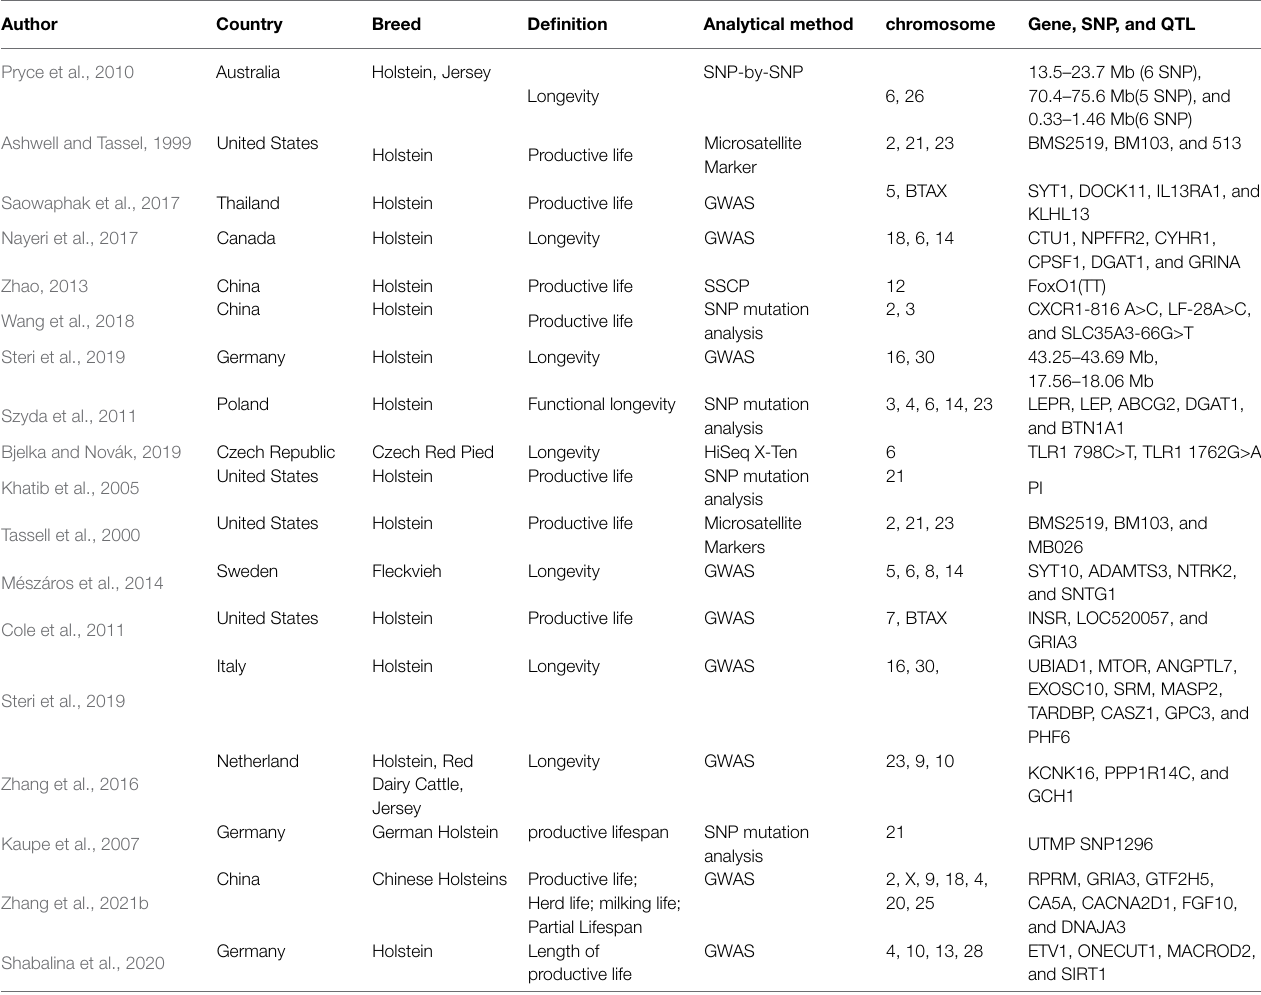
TABLE 3 | Genes, single-nucleotide polymorphisms (SNPs), and quantitative trait loci (QTL) related longevity of